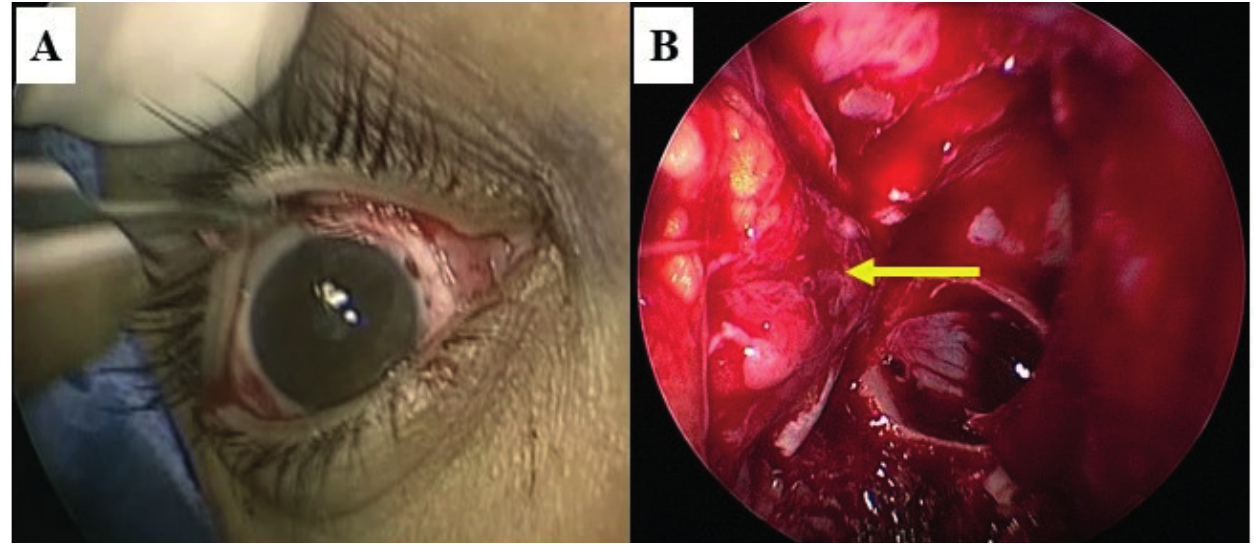
Figure 4. Final result after the MRM anastomoses. A. Eye in anatomical position so that correct tension should be given to anastomosis suture; B. The result of suturing